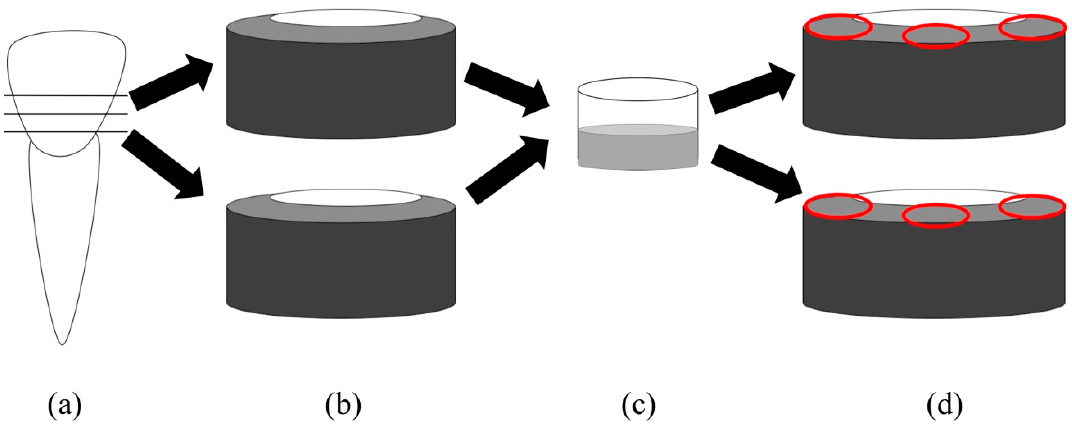
Figure 2. Procedure for the SEM / EDS analysis.( a ) Obtain enamel samples (0.05 mm thick) from bovine incisor teeth ( b ) Applying each primer (SEP, CaP) ( c ) Soak in artificial saliva (immediately, 1 month, 6months) ( d ) Analyzing for 3 points (red circles).